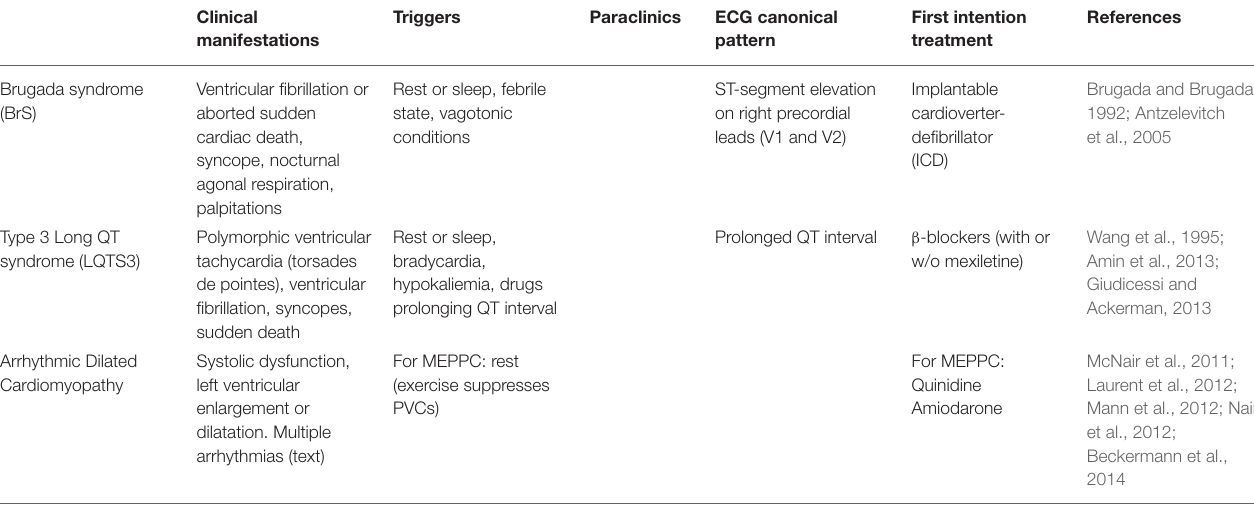
TABLE 2 | Nav1.5 cardiac